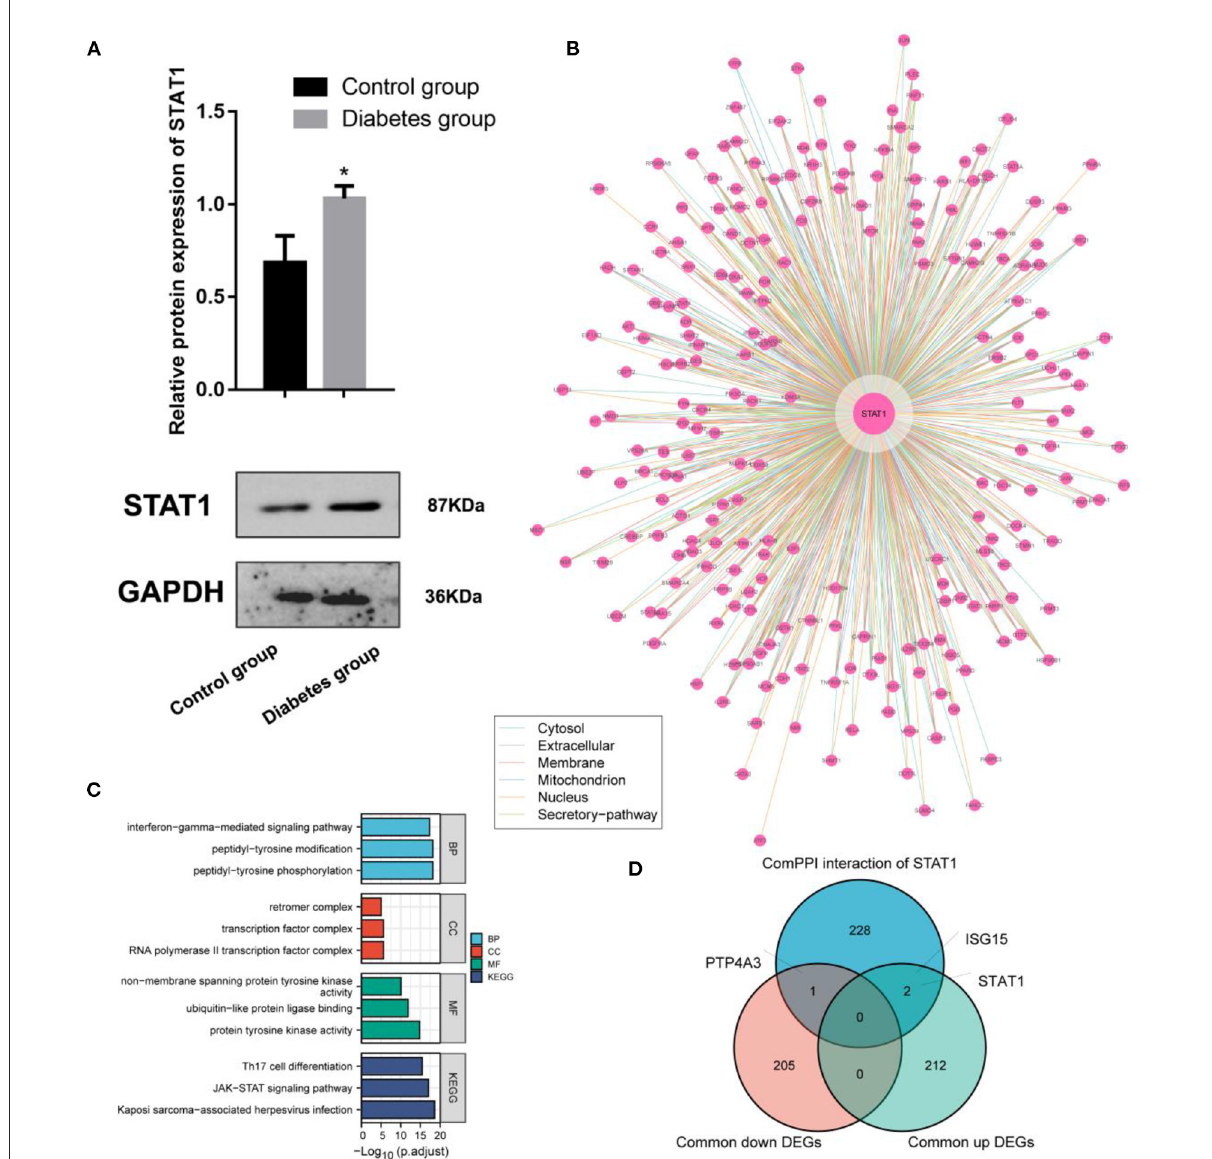
FIGURE5 Interaction and functional analysis of the highly expressed STAT1 protein in diabetes mellitus. (A) WB experimental study to verify the differential expression of STAT1 in ECV-304 cell lines in the high glucose and control groups; (B) Analysis of STAT1 interaction proteins at different cell sites using the ComPPI database; (C) Protein interactions with STAT1 enrichment; (D) Relationships between proteins interacting with STAT1 and genes differentially expressed in diabetes and IA cross-tabulation analysis. * p <